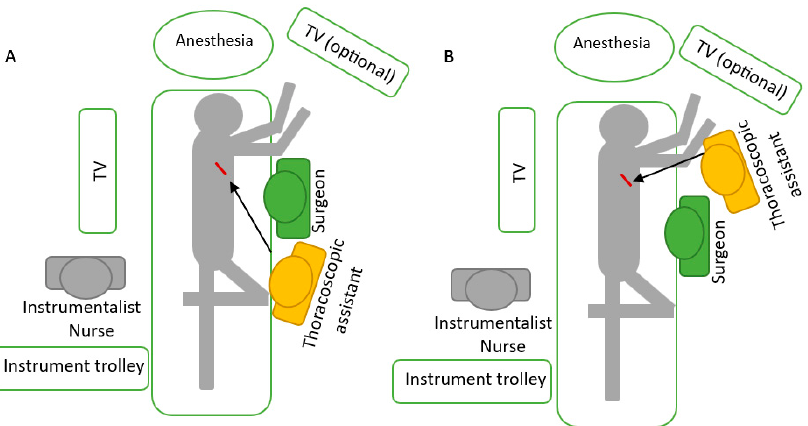
Figure 4. Position of the surgeon, camera assistant and scrub nurse. ( A ) The assistant stands caudally to the surgeon during most steps of the procedure; ( B ) for certain steps in the lower part of the chest, the assistant stands cranially to the surgeon to avoid constant collision with his instruments. [64].